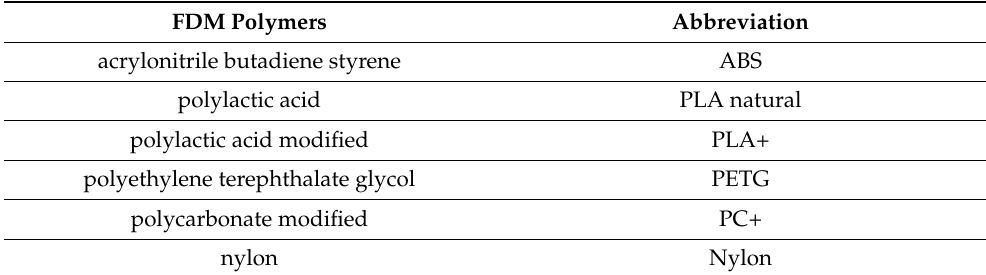
Table 3. Polymers for 3D